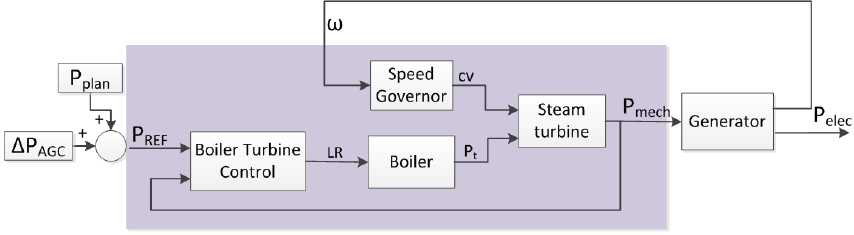
Figure 2. Aggregated CHP model.